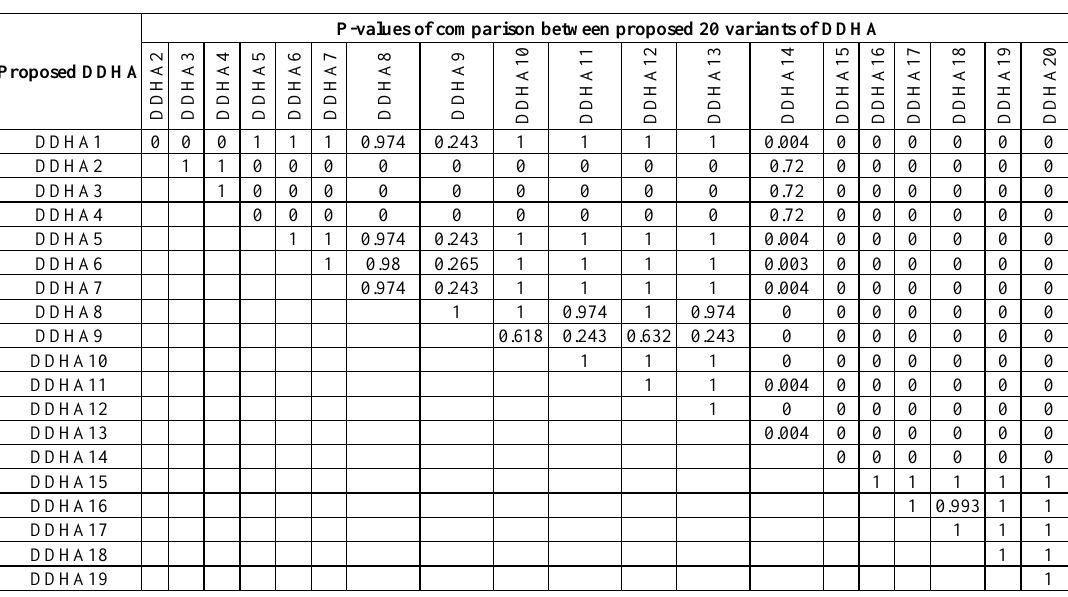
Table 6. Results of multiple comparisons.